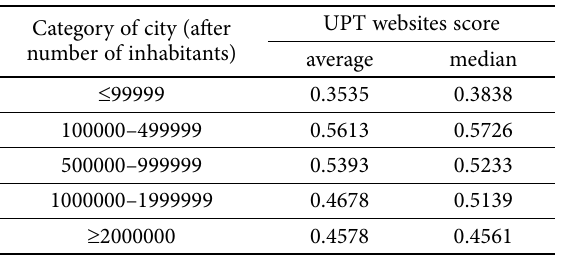
Table 2. UPT websites scores (overview)